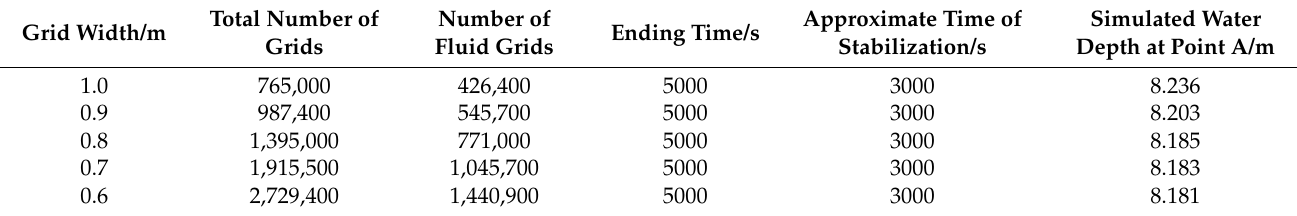
Table 1. Simulation results for different grid